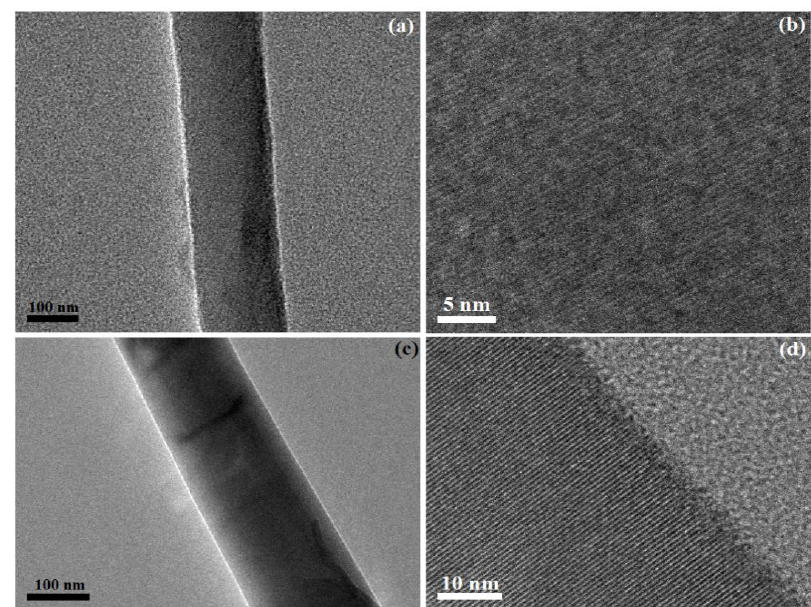
Figure 5. ( a ) TEM of pure GaN nanowire, ( b ) HRTEM of pure GaN nanowire, ( c ) TEM of the 6% Co- doped GaN nanowire, ( d ) HRTEM 6% Co-doped GaN